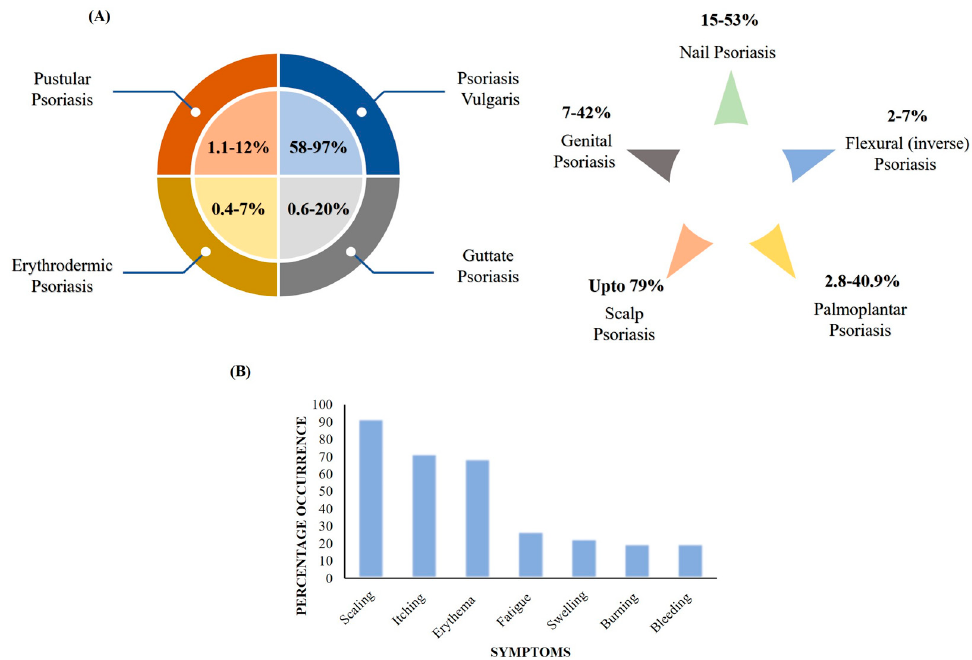
Figure 1. ( A ) Types of psoriasis based on clinical manifestations, anatomical site, and prevalence. ( B ) Common symptoms of psoriasis and percentage occurrence.